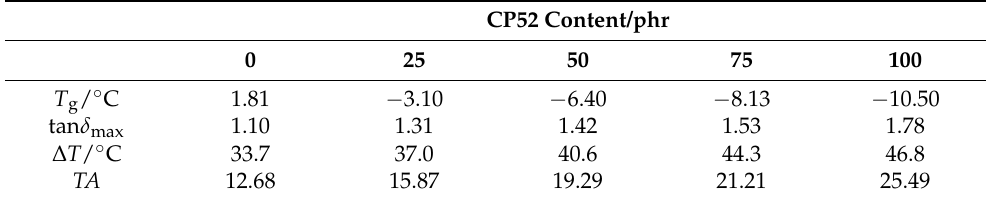
Table 3. Effect of CP52 content on the damping performance of